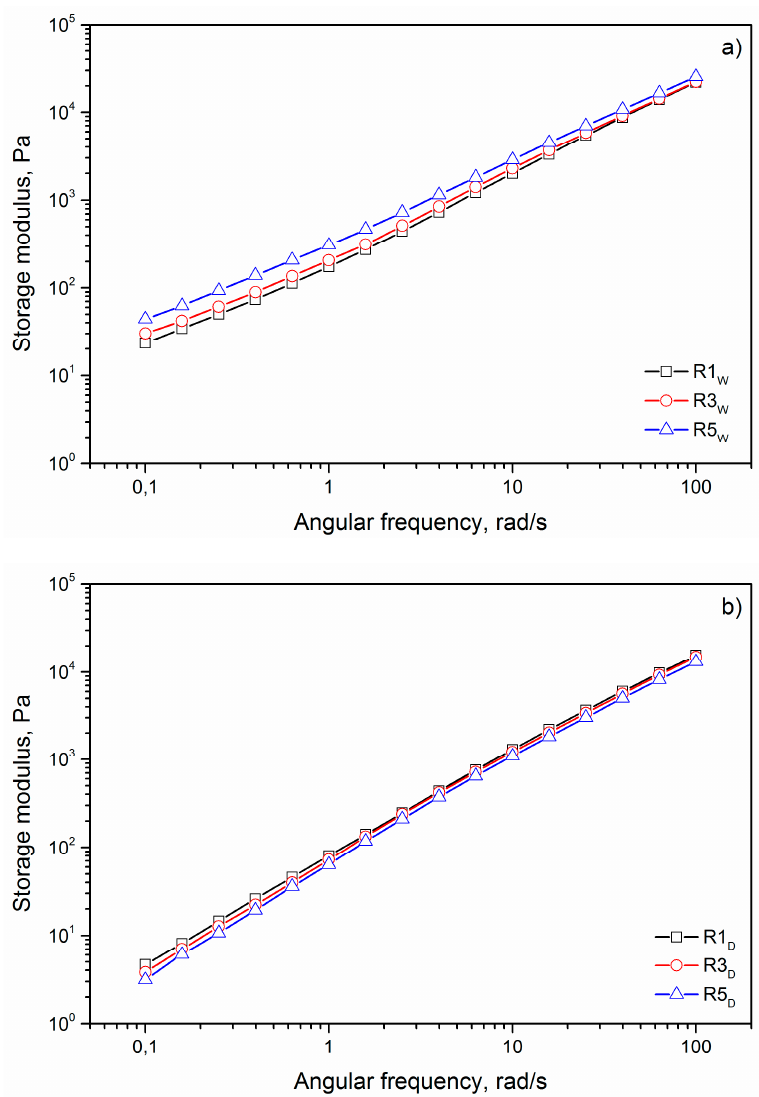
Figure 4. Storage modulus as a function of the frequency for ( a ) dry sample and ( b ) wet sample.